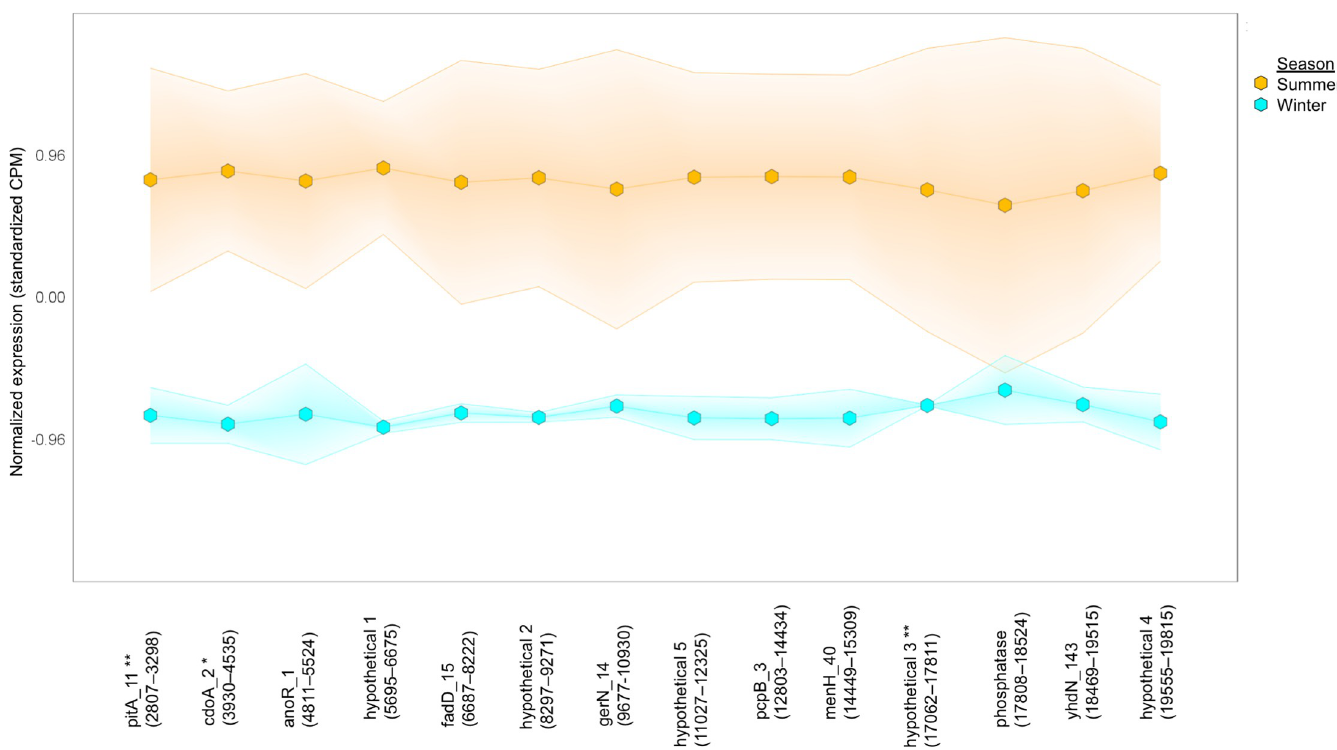
Fig 7. Colocalization and coexpression of metal resistance and secondary metabolite genes. Gradient plot of the differential coexpression of pitA , an MRG encoding a phosphate-uptake transport protein, with genes annotated to be involved in the biosynthesis of a secondary metabolite, homoserine lactone-nonribosomal peptide in contig 4689 (20406 nucleotides long), in summer (orange) and winter (blue). All data met the following criteria: p-interaction � 0.05 in combination with a q-winter/ summer RNA � 0.05, respectively. Nucleotide positions in contig are shown in parentheses.